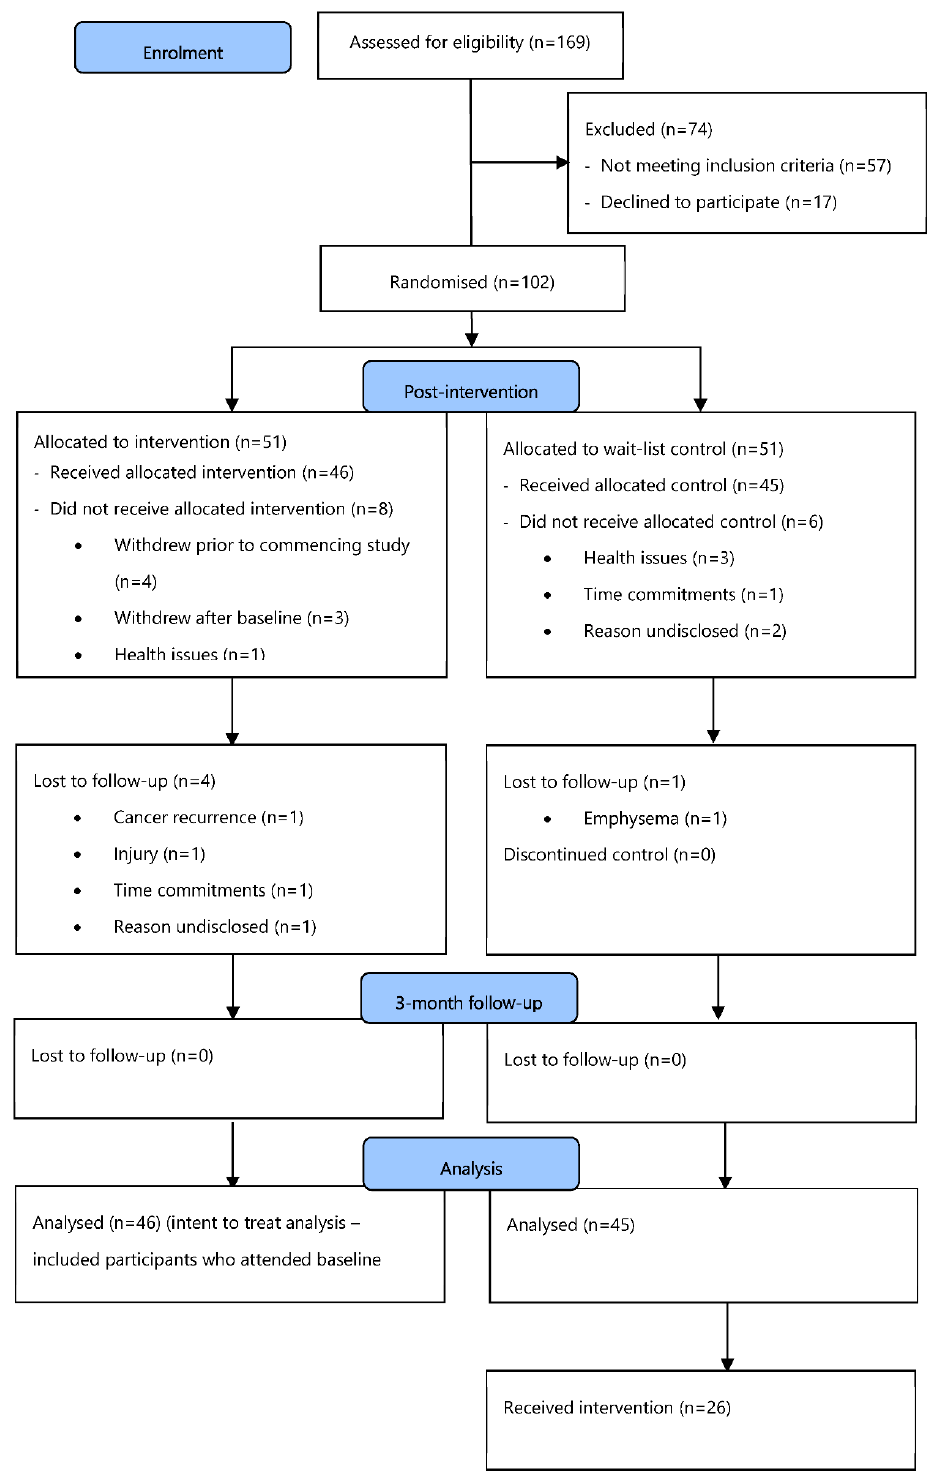
Figure 1. Consort diagram: Participant flow chart.